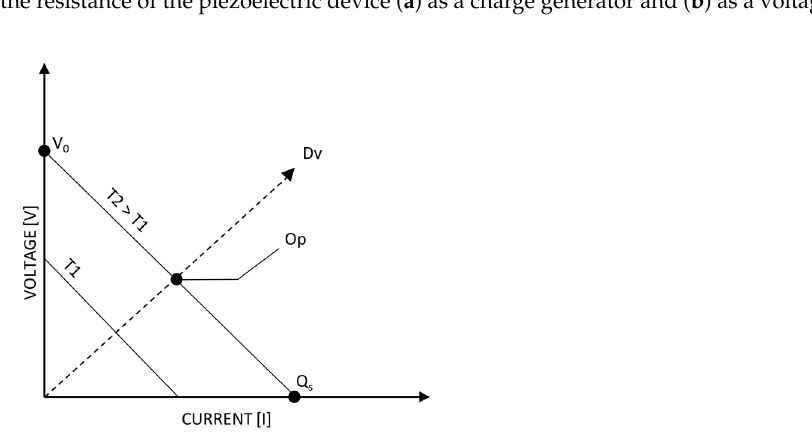
Figure 1. Topologies of a piezoelectric transducer in which Cp and Rp represent the capacitance and the resistance of the piezoelectric device ( a ) as a charge generator and ( b ) as a voltage generator [10].